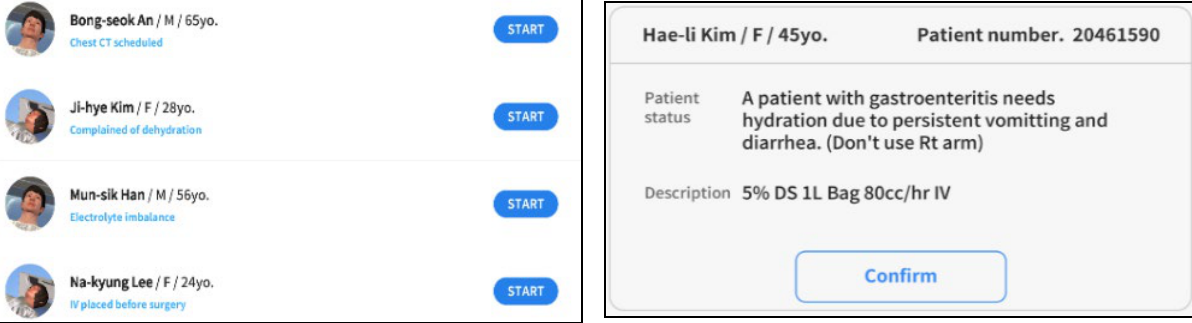
Figure 2. Scenarios in the VRS for IV injection.